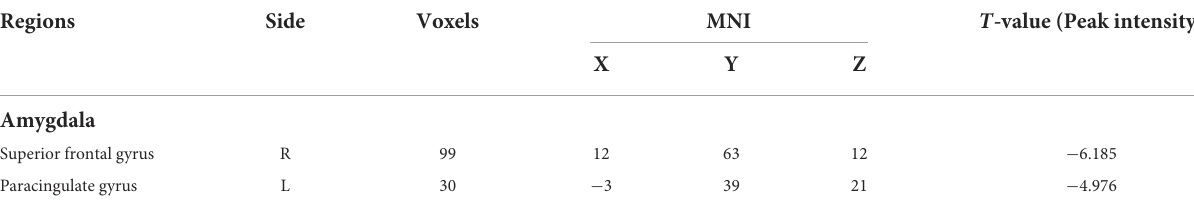
TABLE 3 Comparison of FC between post -acupuncture and pre-acupuncture in subjective tinnitus. Regions Side Voxels MNI T -value (Peak